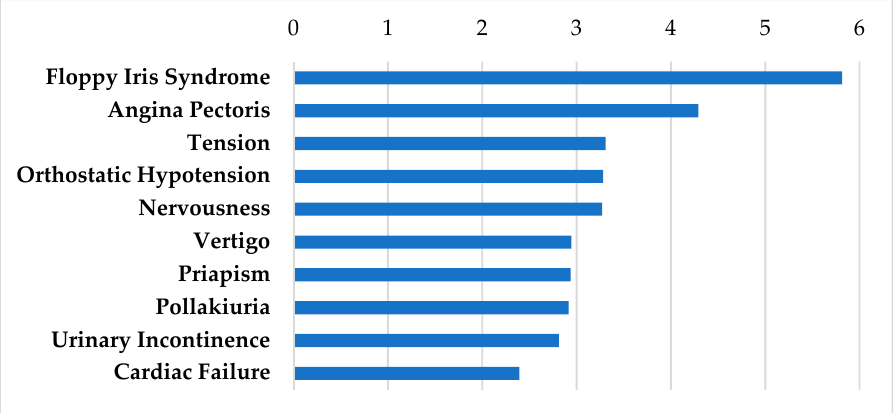
Figure 4. SIDER side effect profile on adrenergic modulators. These drugs include carvedilol, doxazosin, prazosin, terazosin, ephedrine, and tizanidine. Frequencies of the top 10 side effects are shown based on the negative logarithm of their respective p values.